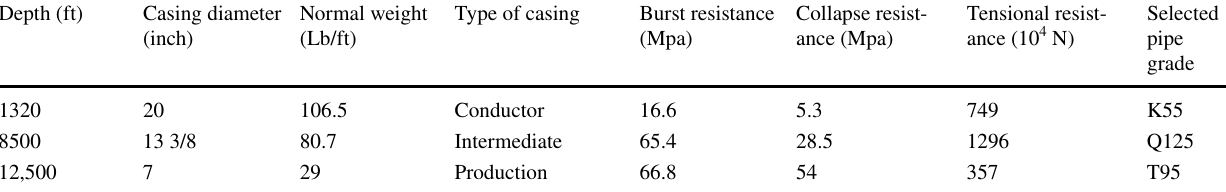
Fig. 11 Kick tolerance graph for conductor and intermediate casing on the top of Atharamura